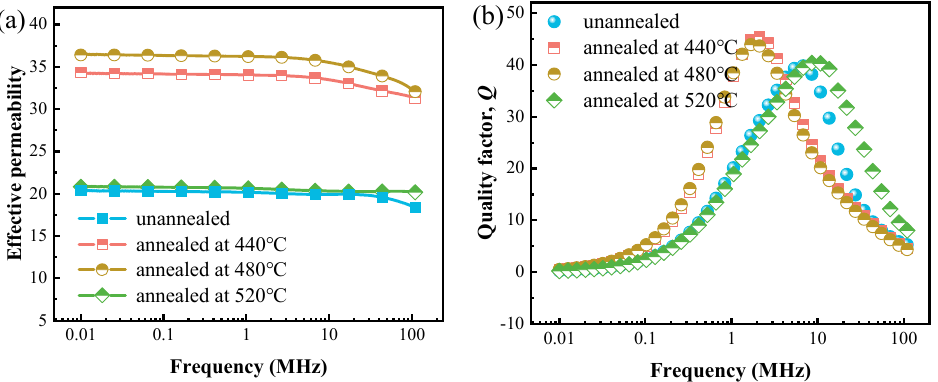
Figure 5. The magnetic properties of the AMPCs: ( a ) effective permeability µ e versus frequency for amorphous powder cores before and after annealing at different temperatures; ( b ) quality factor Q .